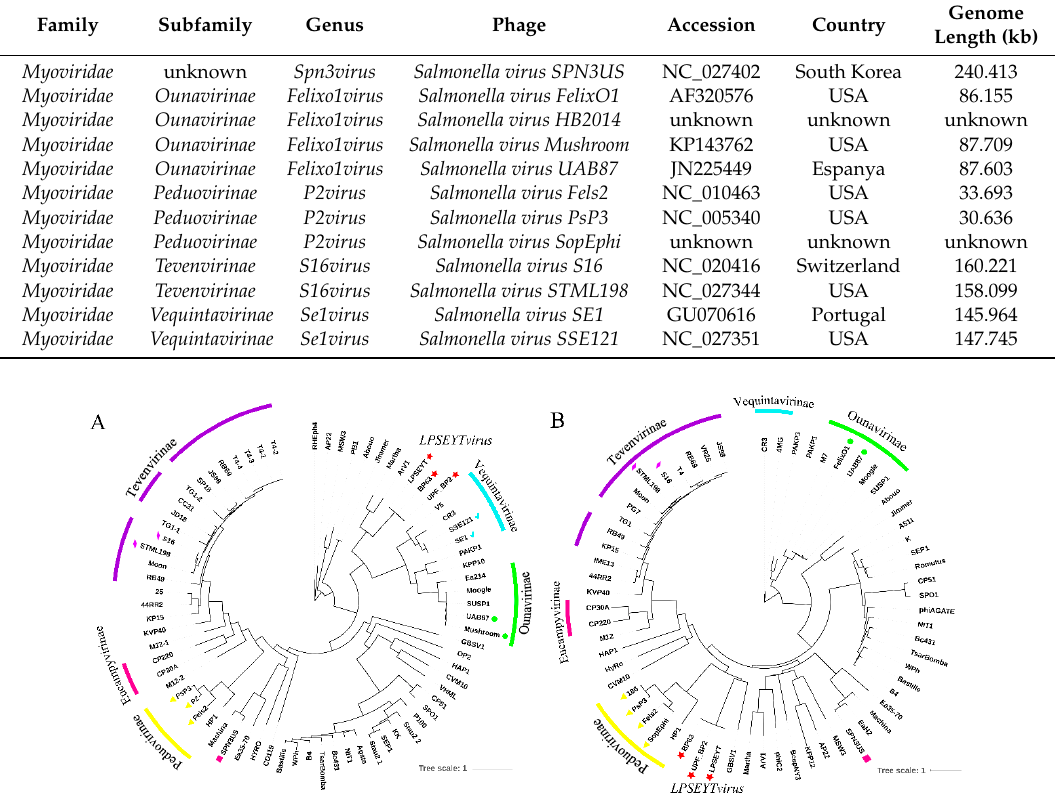
Figure 5. Phylogenetic analysis of selected phages and phages of the new proposed genus LPSEYTvirus based on ( A ) terminase large subunit and ( B ) major capsid protein. The relative distances of each main branch are shown in the figure. The arc with the same color is used to exhibit phages that are classified as the same subfamily. The triangle, rhombus, square, checkmark, and roundness represent the genera P2virus , S16virus , Spn3virus , Se1virus, and Felixo1virus , respectively. The star represents the phages of the new proposed genus LPSEYTvirus in this Table 4. Overview of International Committee on Taxonomy of Viruses (ICTV) recorded genus of Myoviridae that infect Salmonella Spp.